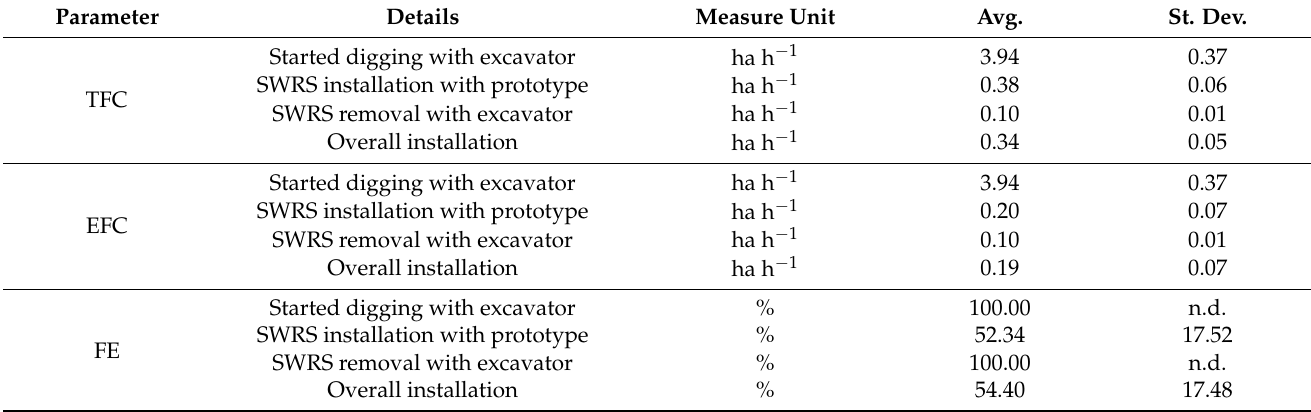
Table 1. Total field capacity, effective field capacity and field efficiency are reported for every phase of SWRS